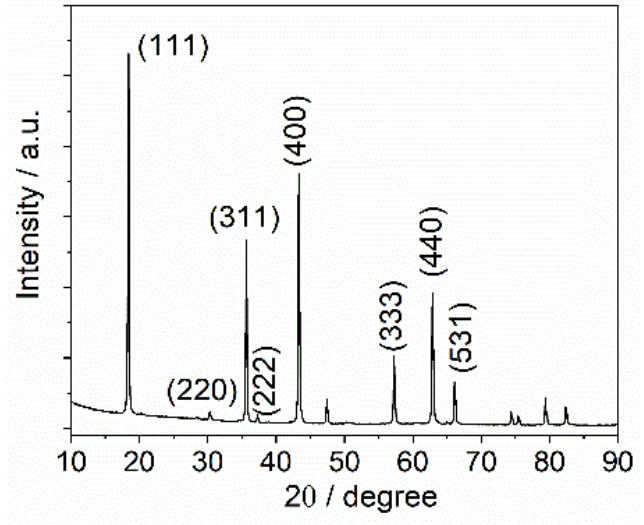
Figure 2. XRD pattern of LTO commercial powder.